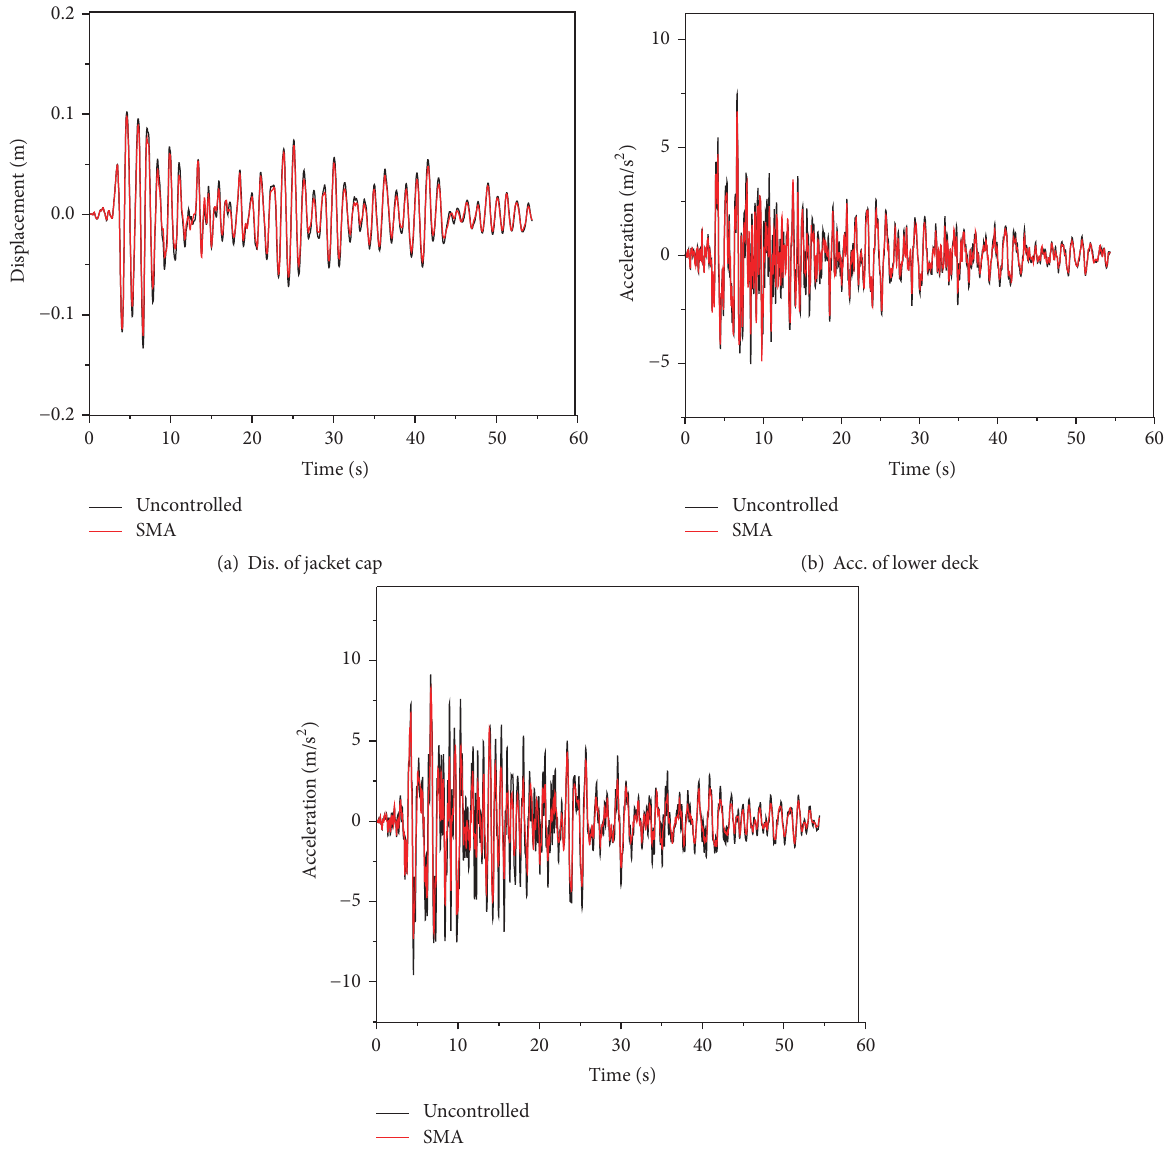
Figure 8: Computational response of JZ20-2MQU model under Taft earthquake